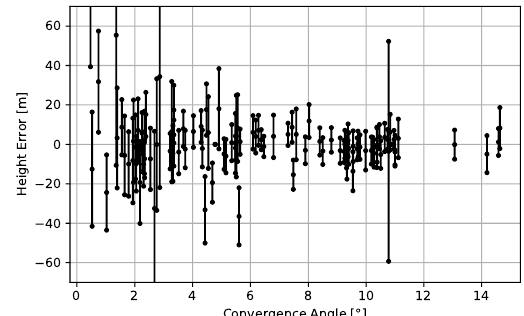
Figure 4. Height error spread vs stereo convergence angle for the 100 selected PlanetScope stereo pairs. The median is given by the central point on the lines, the spread is indicated by the normalized median deviation